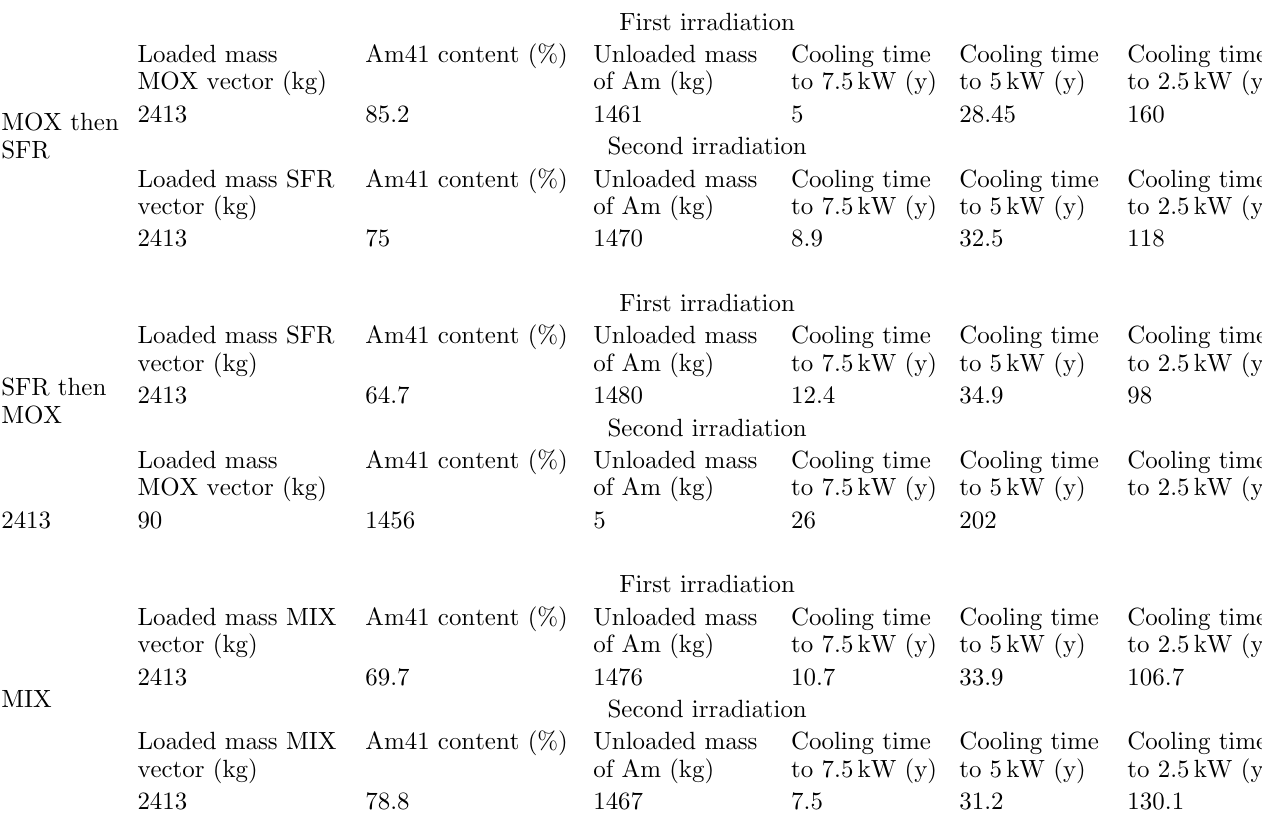
Table 4. Cooling time and americium content for the three strategies studied here